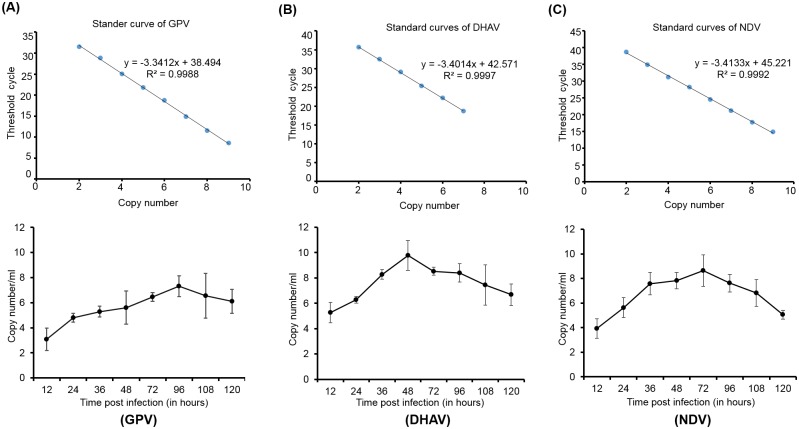
Standard curves of the qPCR and replication kinetics of the propagated viruses in the GEE cells.(A, B, and C; upper panel) For stander curves of the qPCR, the purified recombinant plasmids DNA of pC_VP3, _VP1, and F were used as standard DNA templets. The threshold cycle was plotted against the copy number of the standard DNA templets. Y represents the threshold cycle and R2 represents correlation coefficient. Growth kinetics of GPV, DHAV and NDV viruses in the GEE cell line (A, B, and C; lower panel, respectively). The GEE cell line was infected with indicated viruses at a moi of 0.1 and cellular RNA were collected at different time points (12, 24, 36, 48, 72, 96, 108, and 120 hpi) and then reverse transcribed into cDNA. The viral copy numbers were measured by qPCR. All samples were performed in three independent times and errors bars represent standard deviations.